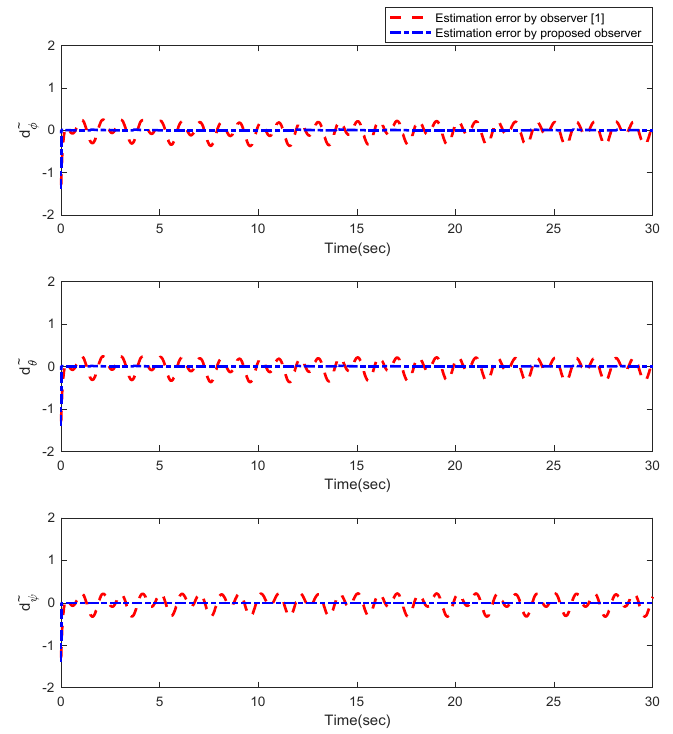
Figure 13. Estimation error of the observer for attitude of quadrotor.